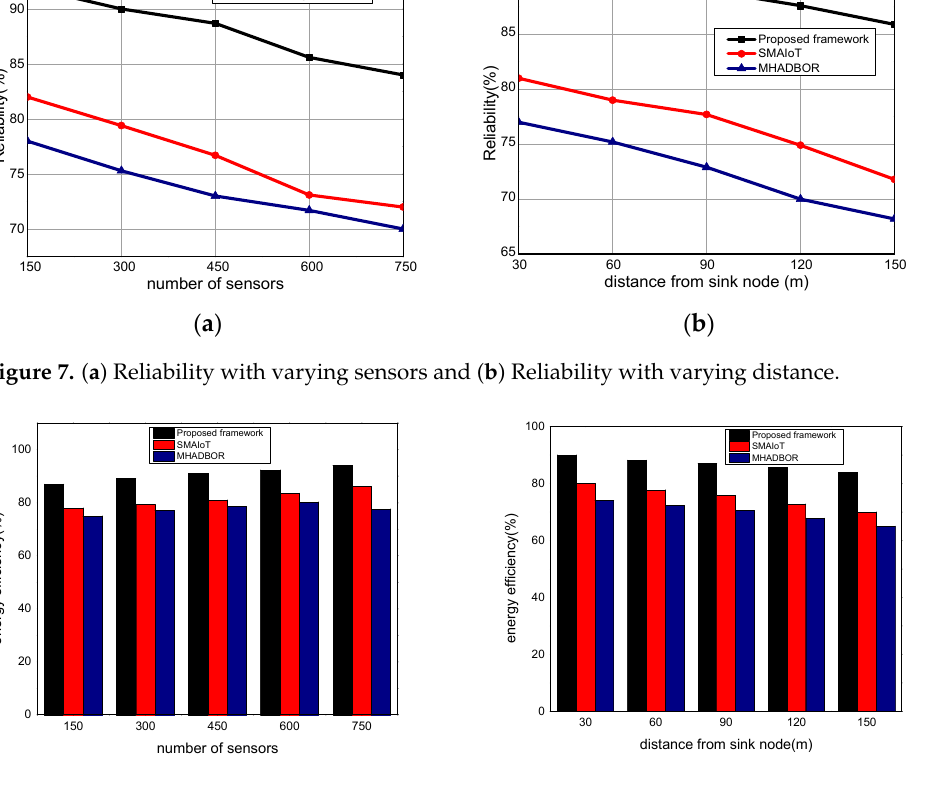
( b ) Figure 9. ( a ) Network connectivity with varying sensors and ( b ) Network connectivity with varying distance. 6. Conclusions With an emphasis on green energy and remote monitoring, smart technologies and agricultural systems have grown significantly in recent years. It controls the plants, soil characteristics, water pressure, and weather-related information, which benefits farmers and increases production. However, limited solutions have been proposed to enhance production in precision agriculture while reducing latency and information disturbance. Furthermore, protecting agricultural data while utilizing the insecure Internet is another significant research challenge. In this study, we presented a framework for providing a farmer communication system to enhance timely delivery through the cooperation of fog systems. This system also incorporates redundant information detection, which reduces network bandwidth inefficiencies. Additionally, the proposed framework employs secu- rity methods to counter privacy attacks on sensing data. The performance results showed the good outcomes of the proposed framework with maximum energy efficiency and de- livery ratio. Furthermore, its performance has proven the improved processing usage in the existence of malicious devices. In the future, we intend to cope with the proposed framework’s scalability and load-balancing issues with the support of a multi-cloud ar- chitecture. Moreover, we would like to integrate security to maintain cloud integrity from the point of users’ perspective.